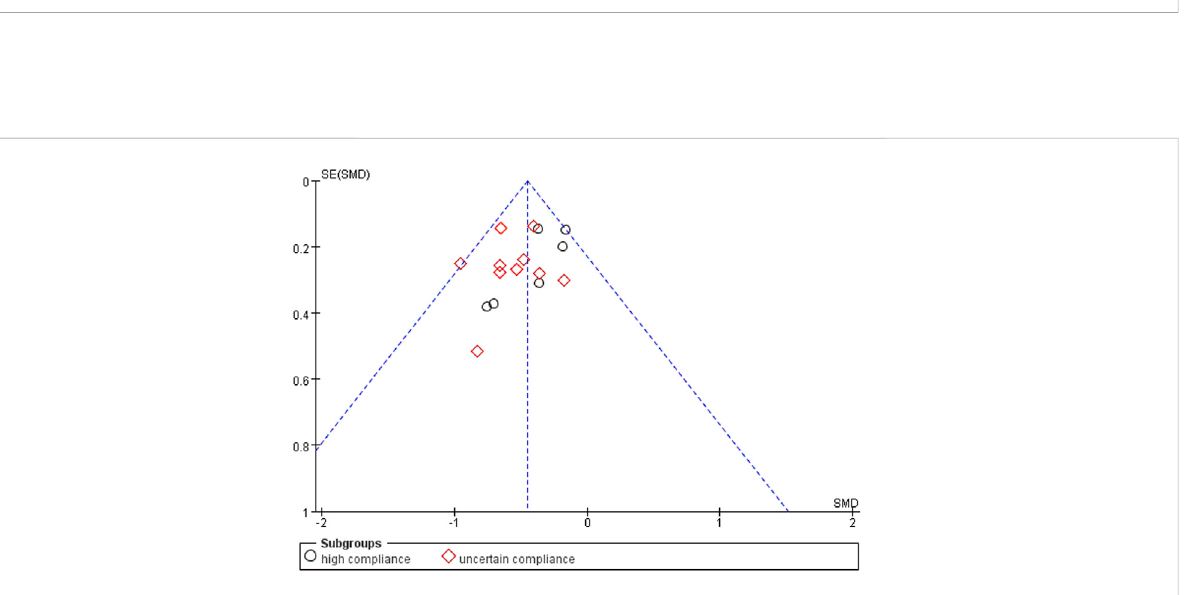
FIGURE 5 Funnel plots for pain: Symmetric funnel plots showed no publication bias. SE, standard error; SMD, standardized mean